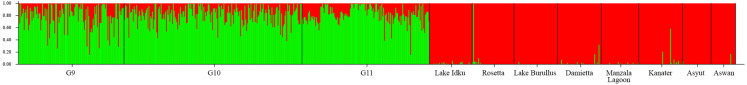
Broad-scale population structure. Structure plot of the three AS generations and the eight wild sampling locations at K = 2. Colors (green and red) represent the two genetic clusters identified. Vertical bar colors are indicative of admixture of the two genetic clusters per individual. The wild sampling locations are ordered via geographical distance order.